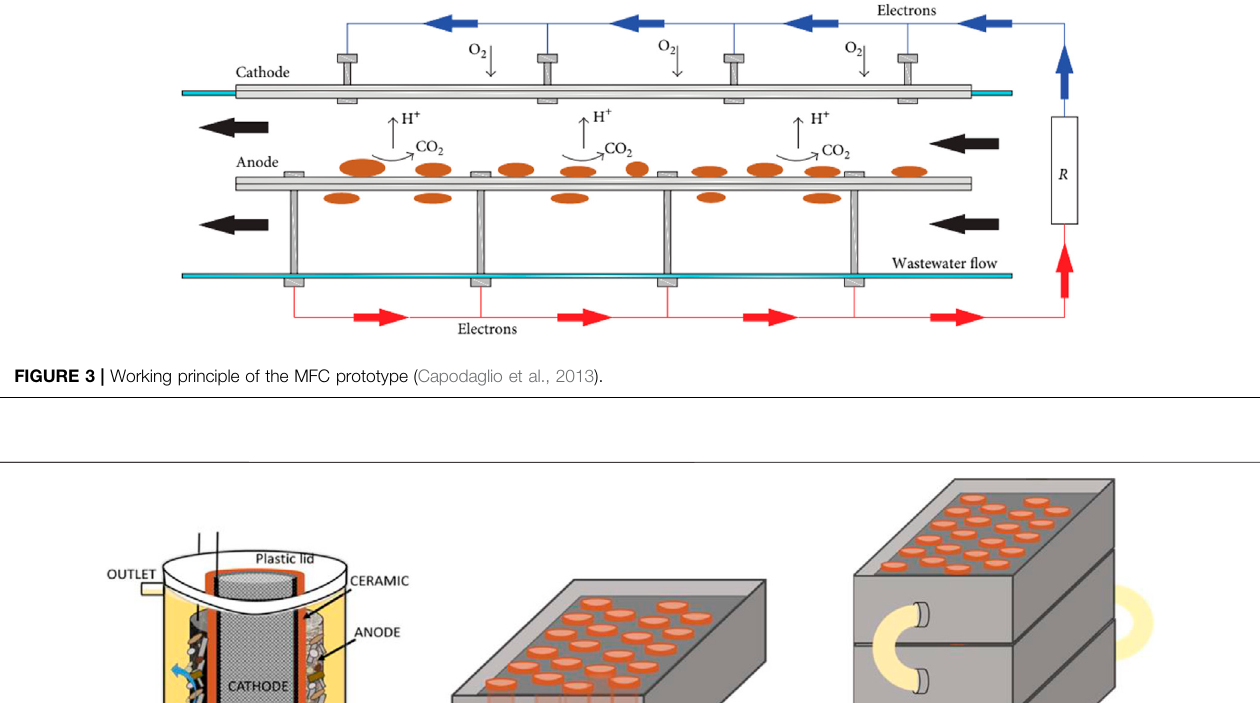
Frontiers in Nanotechnology |